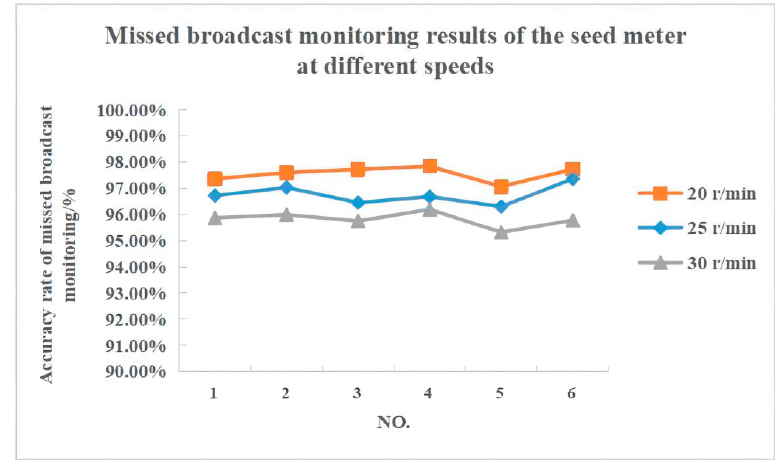
Figure 9. The missed broadcast monitoring curve of the seed meter at different